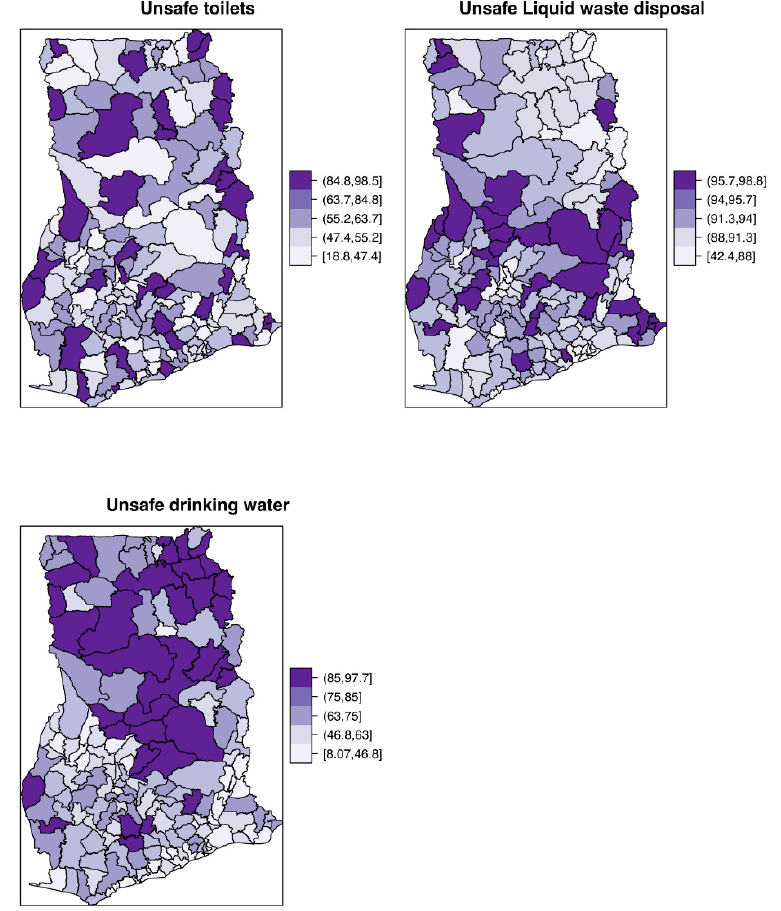
Figure 2. Spatial distribution of the constructed demographic covariates for proportions with unsafe toilets, unsafe drinking water, and unsafe liquid waste disposal.